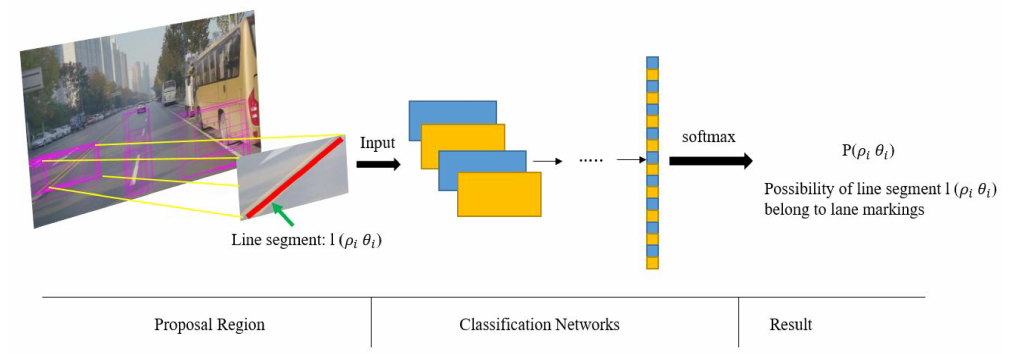
Figure 12. Line segments classified by the proposed network into the probabilistic Hough space which records the the confidence probability of each line segment (image obtained from